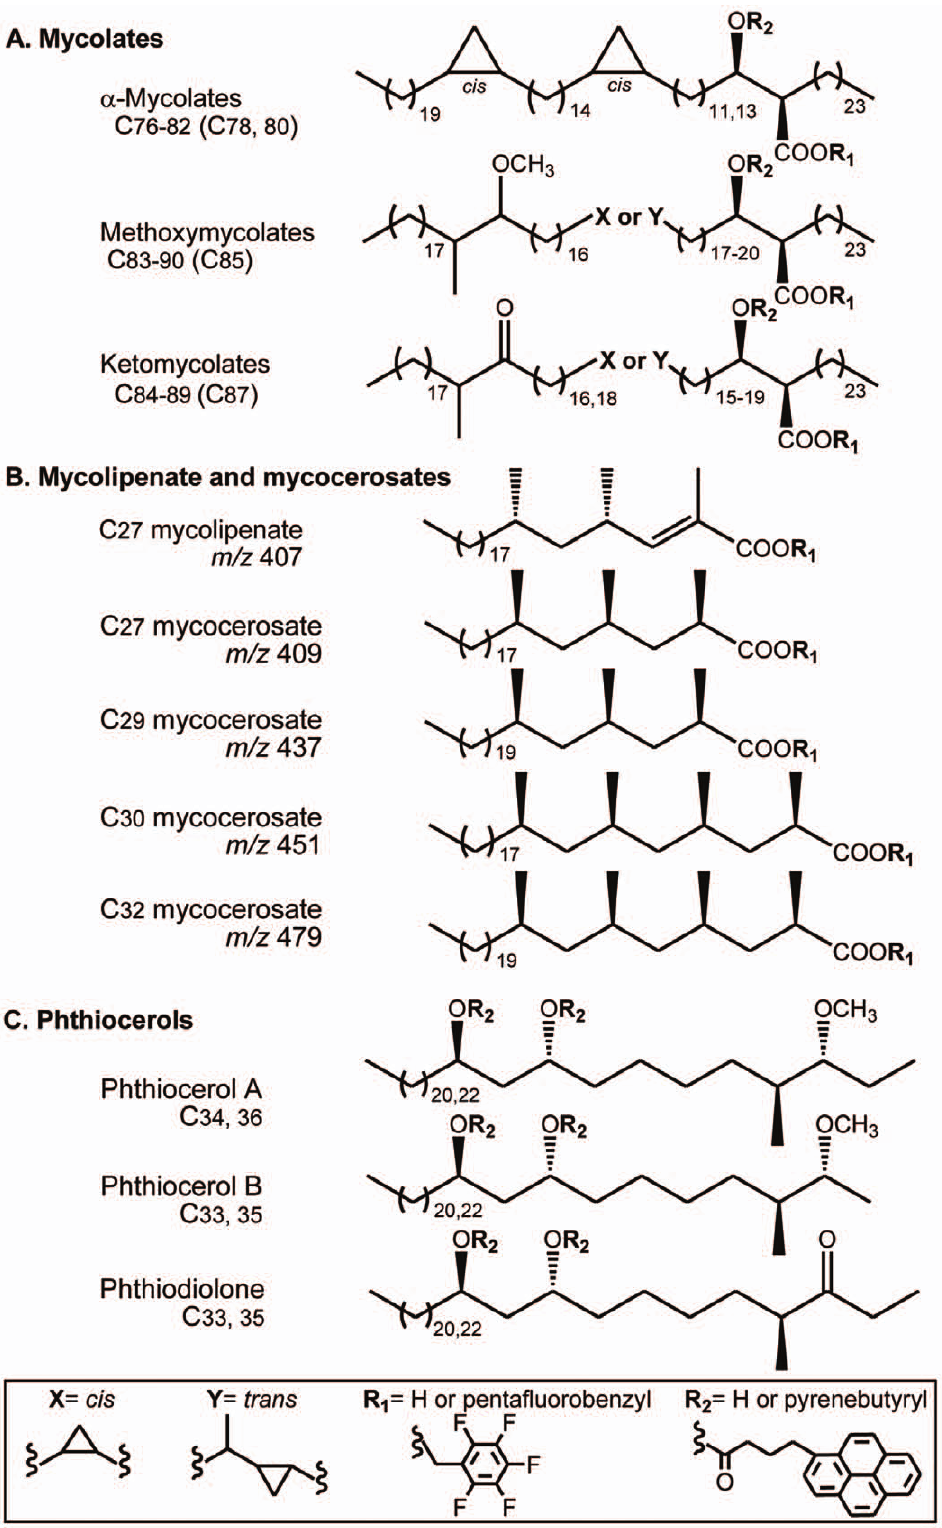
Figure 1. Lipid biomarkers for M.tuberculosis . A. Generalized structures of the a -, methoxy- and ketomycolates; the main components are in brackets. B. Structures of mycolipenate and mycocerosates, showing ions used for selected ion monitoring on NI-CI GC-MS analysis. C. Structures of members of the phthiocerol family.